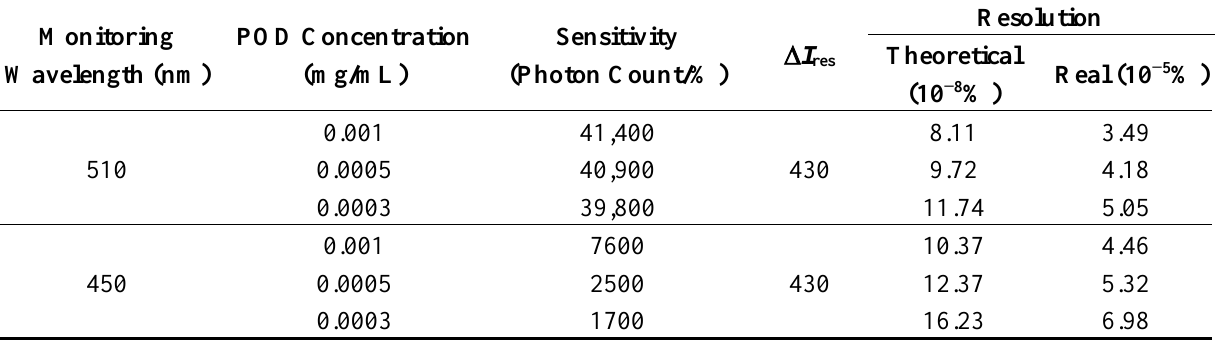
Figure 7. Stability evaluation of the photon counter. Table 2. Sensitivity and resolution of the proposed